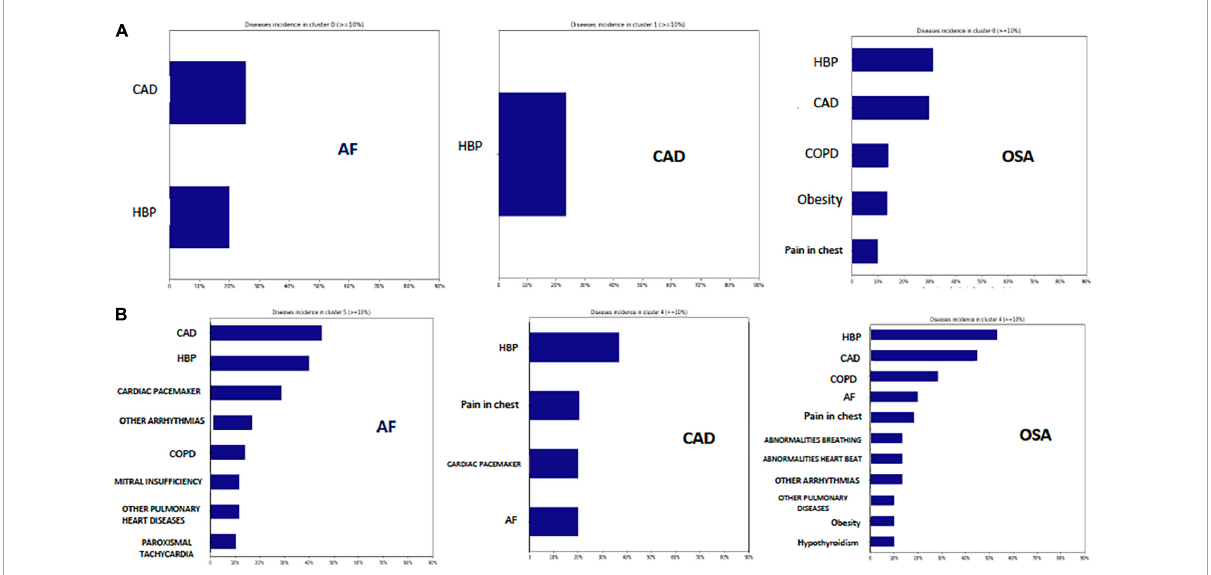
FIGURE1 Clusters. (A) Clusters with the major number of individuals (66–91.5%) for AF, CAD, and OSA. CAD and HPB were the most prevalent diseases in AF cluster, HPB was the most prevalent diseases in CAD cluster, and HBP and CAD were the most prevalent diseases in the OSA cluster. (B) Show the same prevalent diseases for each cluster (4.6–16% of individuals), but with more comorbidities in each group. CAD, Coronary artery disease; HBP, High blood pressure; COPD, Chronic obstructive pulmonary disease.